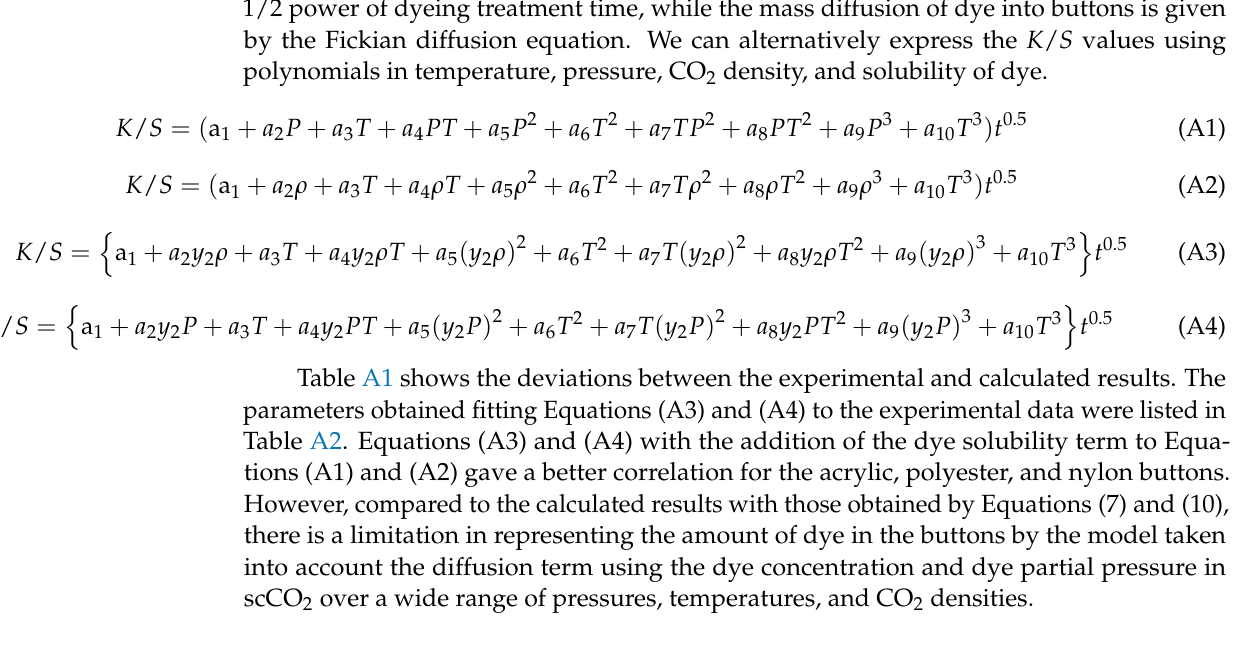
pressure and temperature. Table S3: The experimental K / S values for casein button at pressure, temperature, and treatment time, along with CO 2 density and solubility of dye at every pressure and temperature. Table S4: The experimental K / S values for nylon button at pressure, temperature, and treatment time, along with CO 2 density and solubility of dye at every pressure and